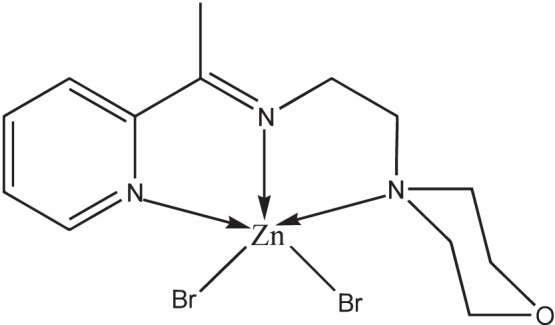
Chemical structure of the zinc (II) complex [38].